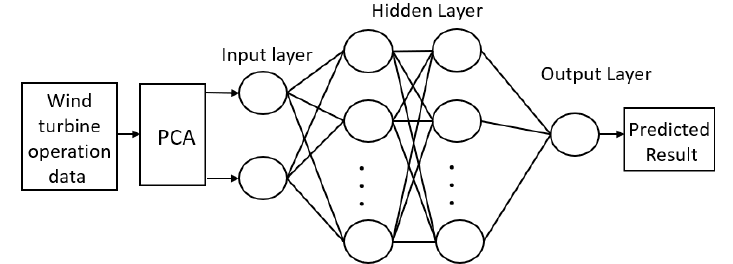
Figure 4. Topology structure of LSTM model.